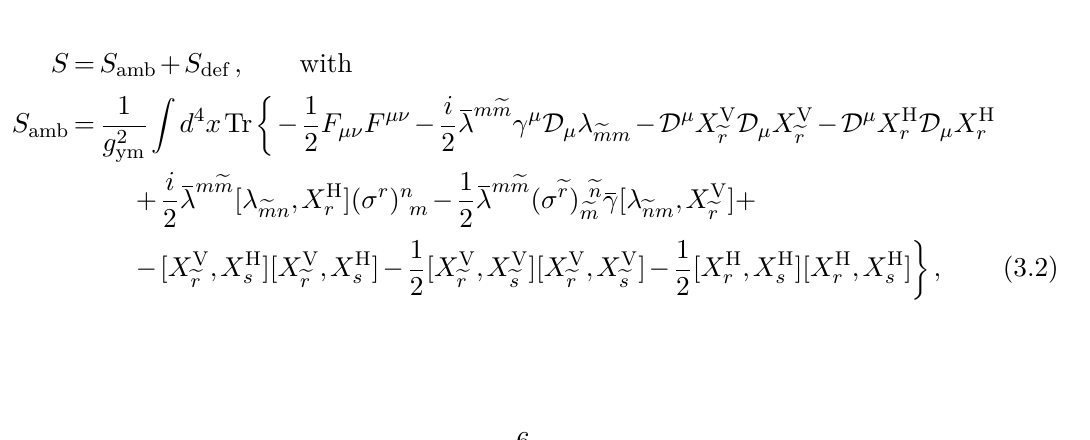
are determined by the values of H as x 2 → ±∞ r